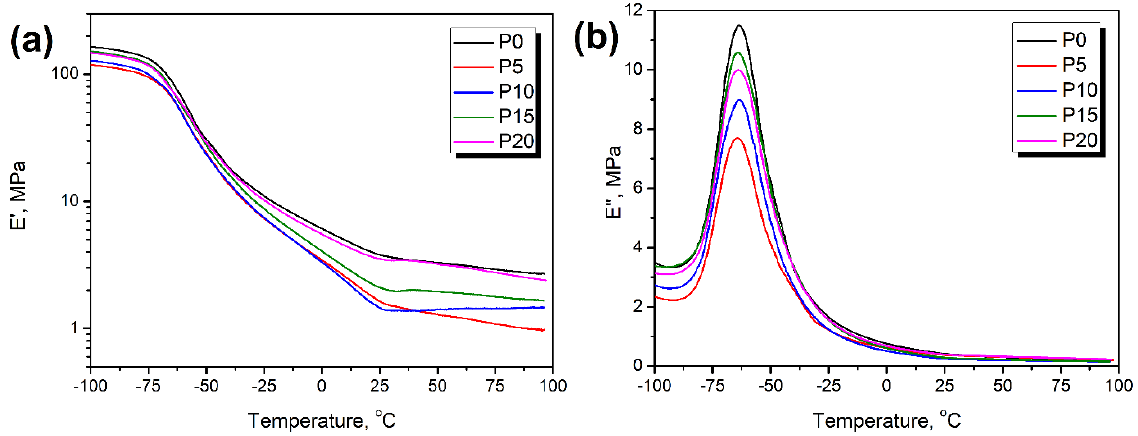
Figure 8. Temperature plots of ( a ) storage modulus and ( b ) loss modulus for prepared foams.